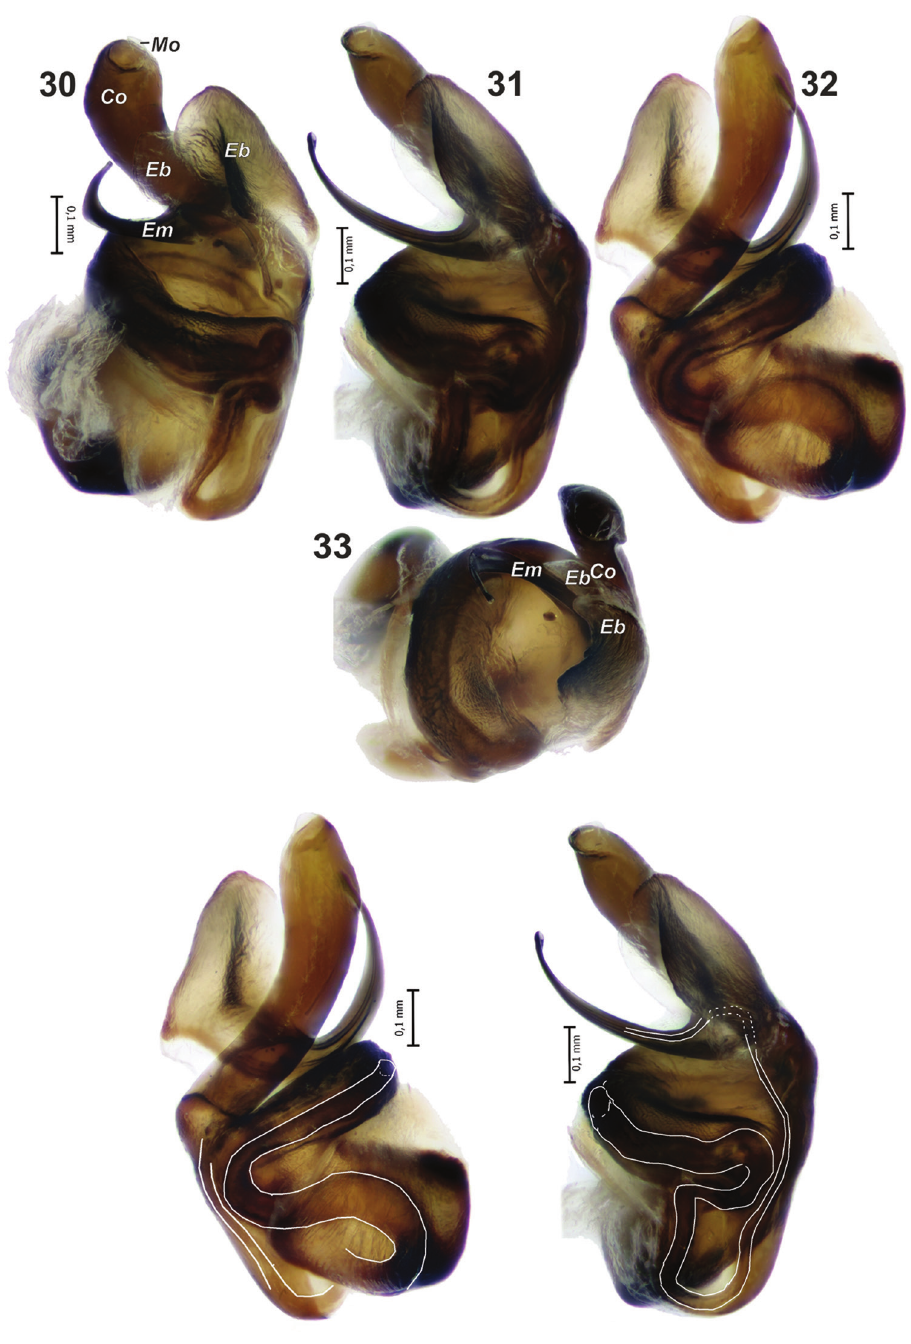
Figures 30–33. Bulb of Metellina orientalis . 33 from above. Abbreviations: Co conductor Eb embolar base Em embolus Mo membranous outgrowth. Scale bars 0.1